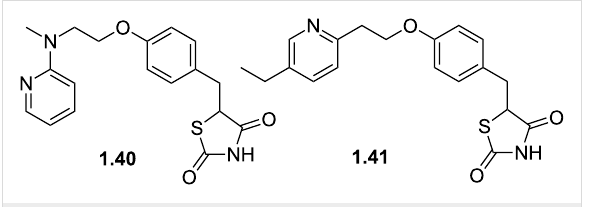
Figure 1: Structures of rosiglitazone ( 1.40 ) and pioglitazone ( 1.41